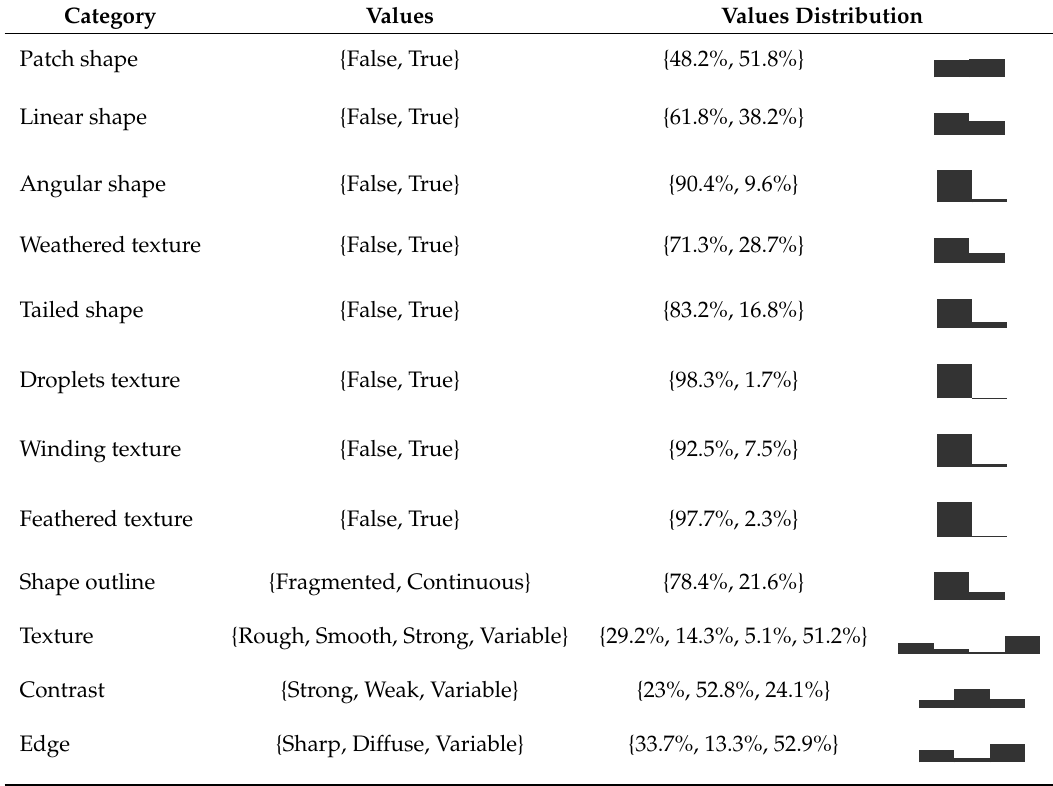
Table 1. The 12 categories used to classify each oil spill. The possible values assumed by each category are reported in the second column. The distribution of the values for each category assumed by the elements in the dataset is reported in the third column, by using both numerical percentages and a histogram; e.g., 61.8% of the data samples do not have a linear shape and 38.2% have a linear